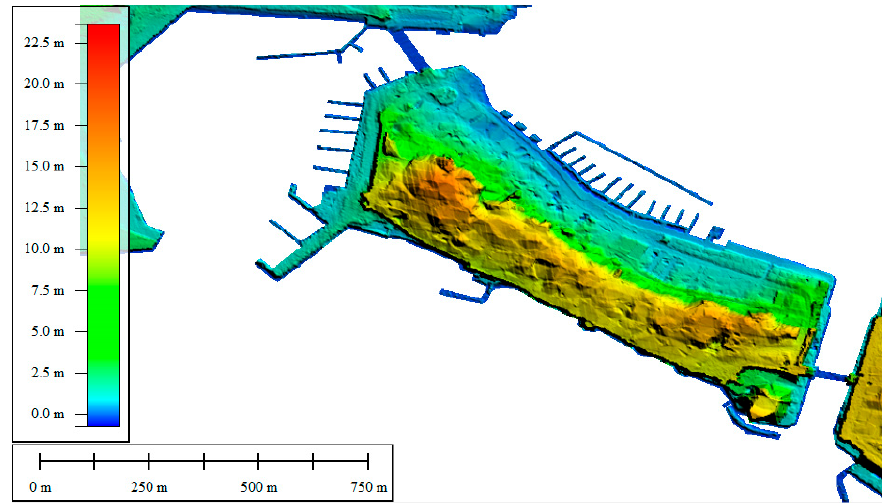
Figure 11 . Digital terrain model (DTM) of study area displayed in the Global Mapper software Figure 11. Digital terrain model (DTM) of study area displayed in the Global Mapper